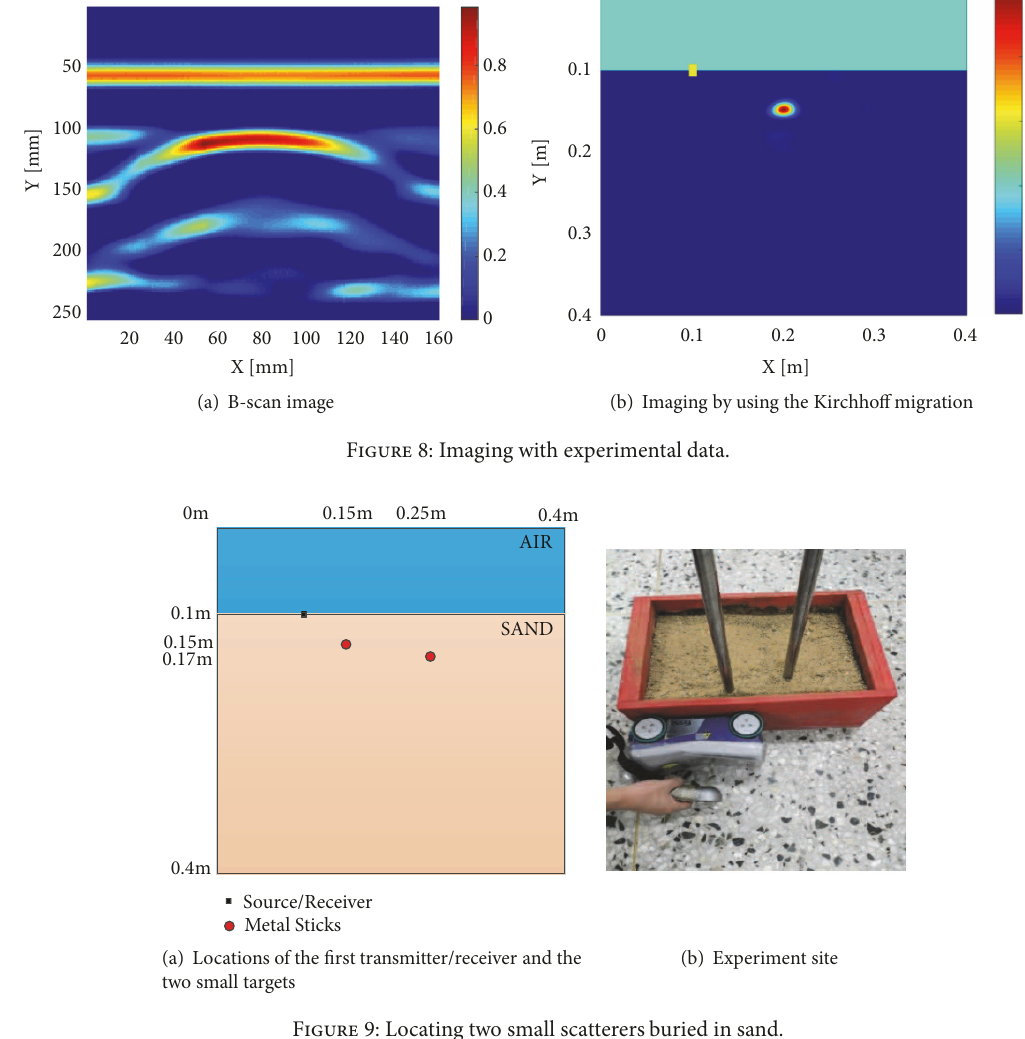
Figure 9: Locating two small scatterers buried in sand.